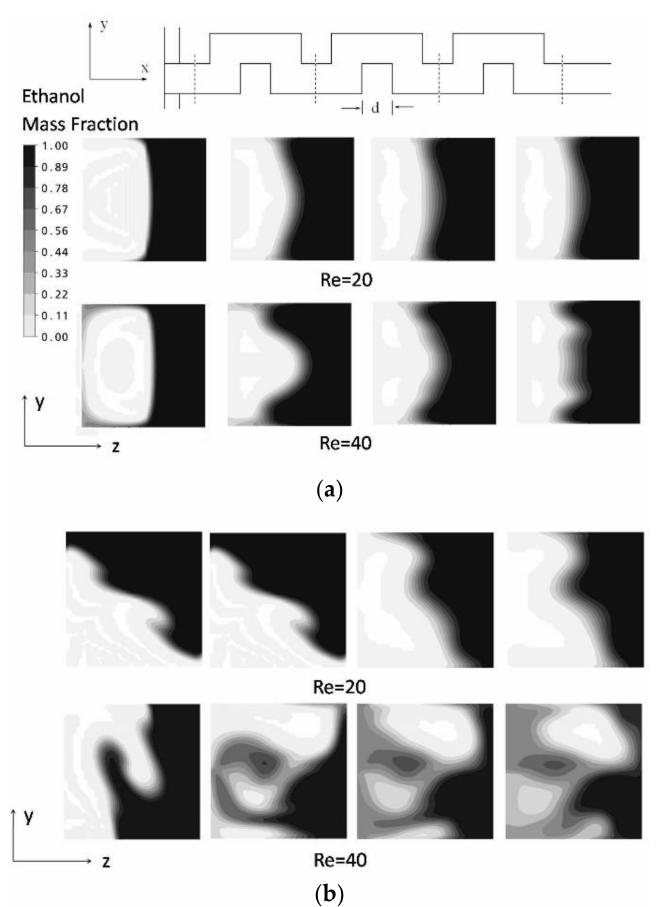
Figure 9. Mass fraction distributions of ethanol on the y-z planes at the initial four axial positions (shown by the dotted lines) in the planar serpentine channel at Re = 20 and 40 integrated with the ( a ) simple micro T-mixer and ( b ) vortex micro T-mixer.